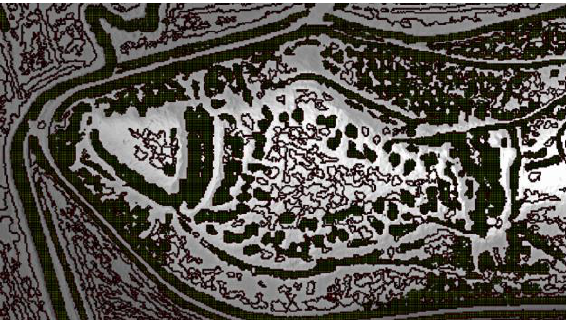
Figure 7. Radkov – profiles of GPR survey, 2015